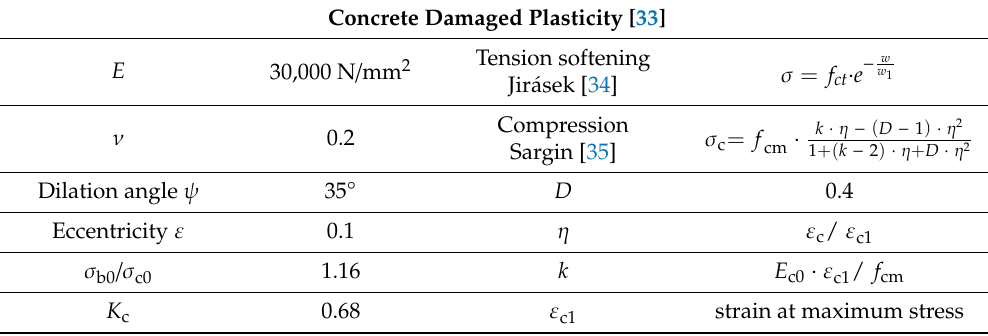
Figure 3. Comparison of experimental and numerical results based on tests by Paulay and Loeber [10] with constant crack width w : ( a , c ) shear stress-shear deformation curve and ( b , d ) shear stress-normal (restraining) stress relationship. Table 2. Parameters for the numerical simulations with concrete damaged plasticity (CDP).